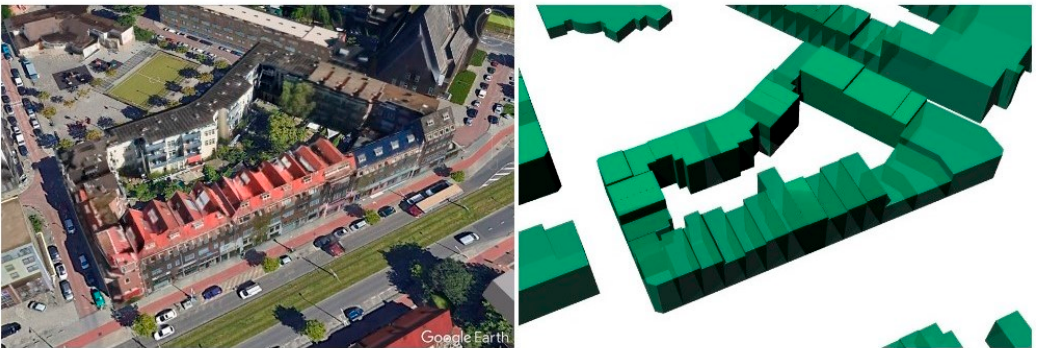
Figure 2. Satellite image from Google Earth of the Hilleshuis neighbourhood ( left ). “Level of Detail 1” (LOD1) model of multiple adjacent buildings (right).